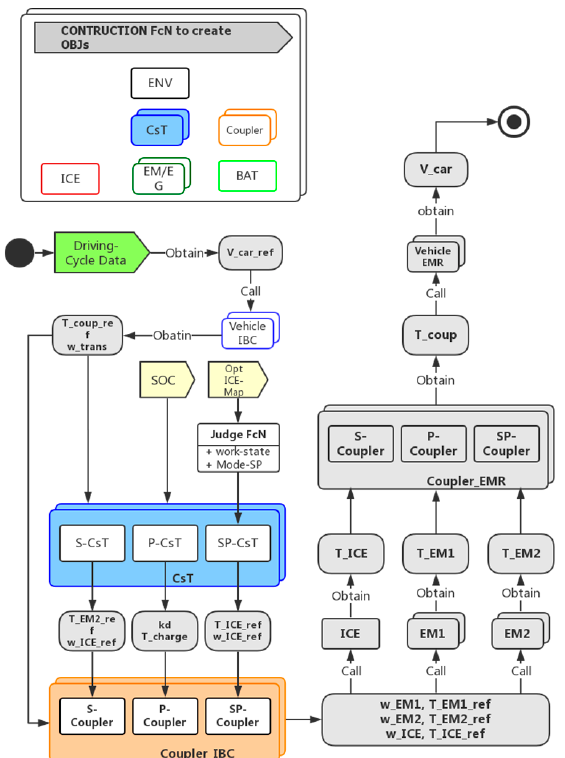
Figure 11. UML of electric motor (EM) OOP model (power source).